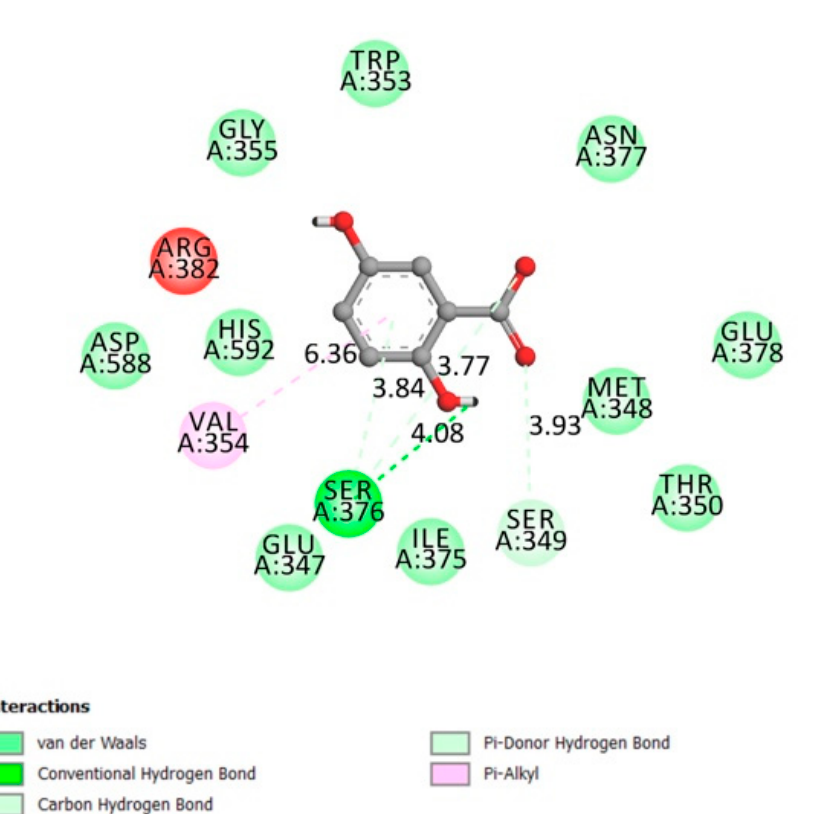
Figure 2. Two-dimensional scheme of the GA interactions with dipeptidyl-peptidase 4 (DPP4) re- ceptor.